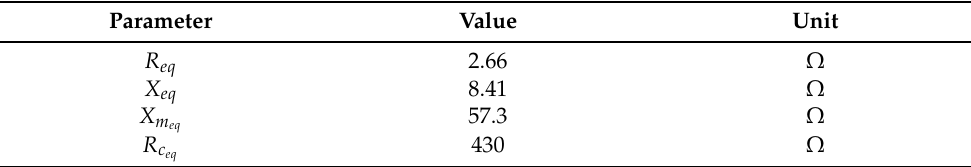
Figure 15. Rotary-transformer-coupled RDFIG per phase: ( a ) full equivalent circuit and ( b ) simplified equivalent circuit. Table 9. Rotary transformer–RDFIG equivalent circuit